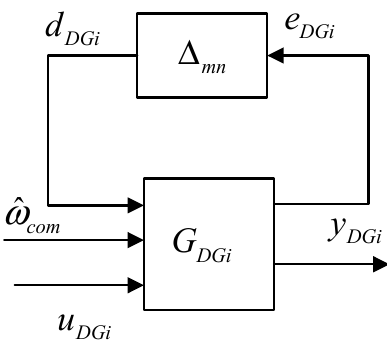
Figure 6. LFT configuration of a DG unit.